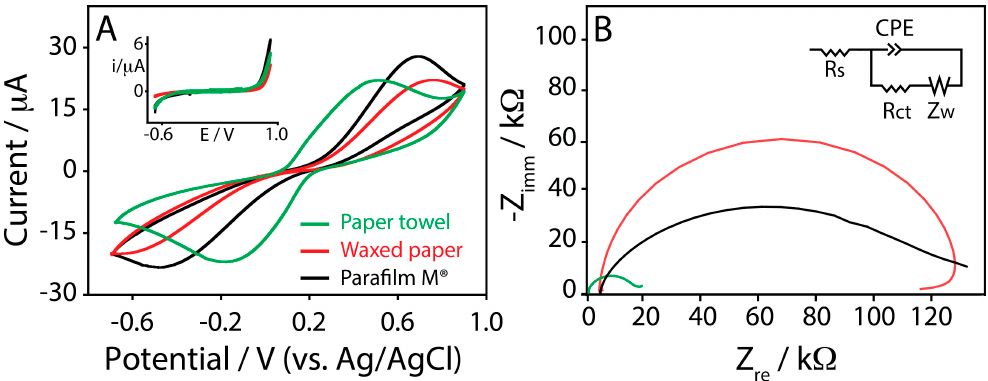
Figure 3. ( A ) Cyclic voltammograms performed in 2 mM